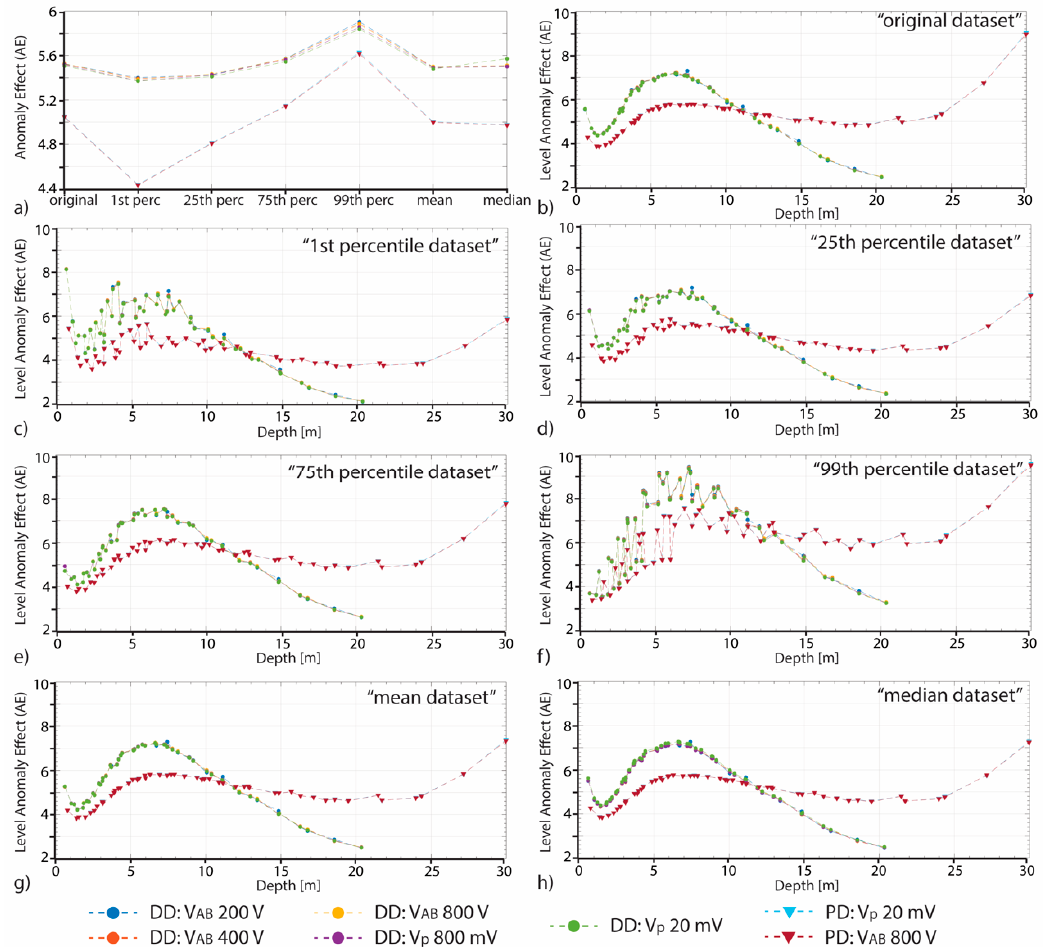
Figure 7. ( a ) The DD (marked with dots) and PD (marked with triangles) global anomaly effect (AE) for each original and simulated dataset. ( b – h ) The DD and PD level anomaly effect (lAE) for the original and simulated (1st percentile, 25th percentile, 75th percentile, 99th percentile, mean, and median) datasets. The normalized ERT-error ( δ ERT norm , see Equations (5) and (6)) of the mean simulated datasets, obtained for each input voltage, is shown in Figure 8. For the DD array, apart for the input voltage equal to 200 V, the highest errors of the inverted models are located within the first 5 m of depth from the ground surface and at a distance of [35 m–40 m] in correspondence of a high resistivity anomaly. The normalized ERT-errors of each simulated dataset for the 200 V input and the PD δ ERT norm show the highest